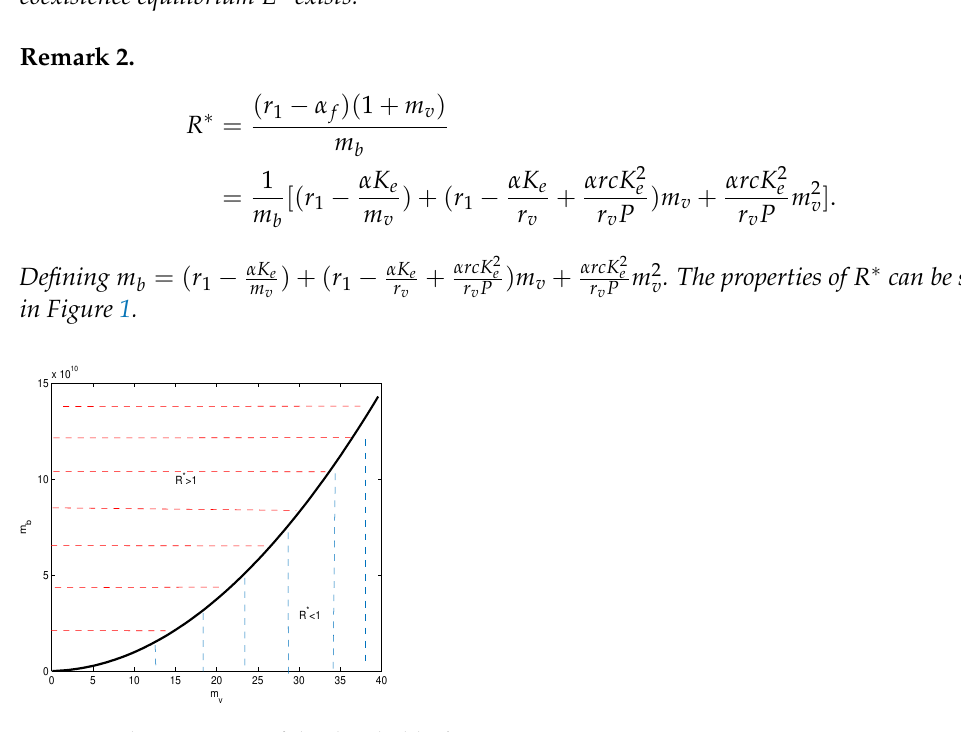
Figure 1. The properties of the threshold R ∗